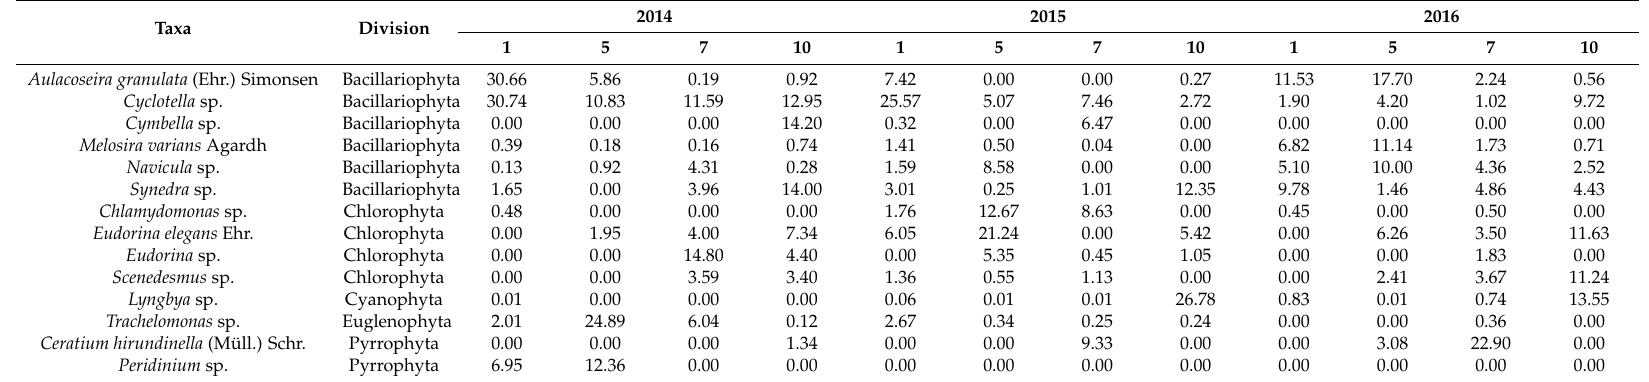
Table A4. Indicator taxa of phytoplankton assemblages before, during, and after water level increase in the Danjiangkou Reservoir. Taxa Division Year Water Level Change Indicator Value p Value Trachelomonas